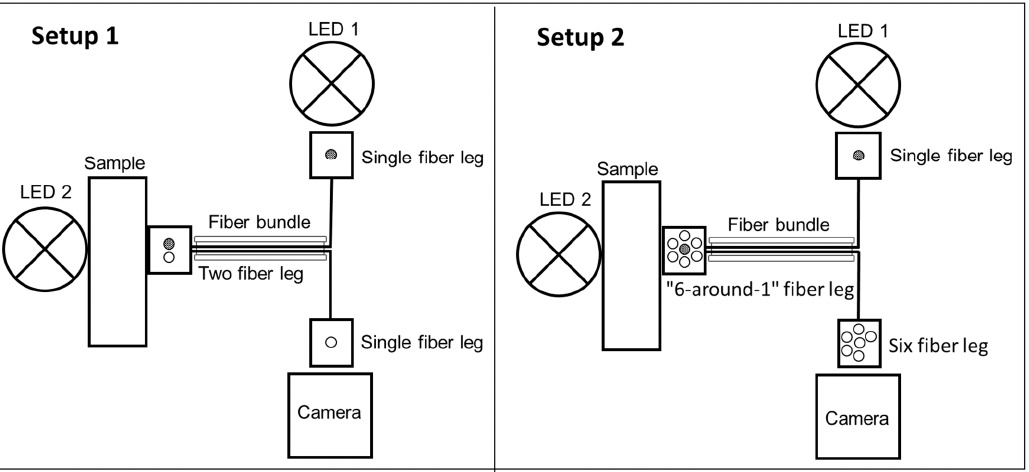
Figure 2. Assembly of the components for reflection and transmission measurements for Setup 1 and 2: light is applied from LED 1 and enters and exits at the same fiber bundle or light from LED 2 passes through the filament and transmitted light is collected into the fiber bundles. A picture of the fiber leg (single- or six-fiber leg) was taken by a